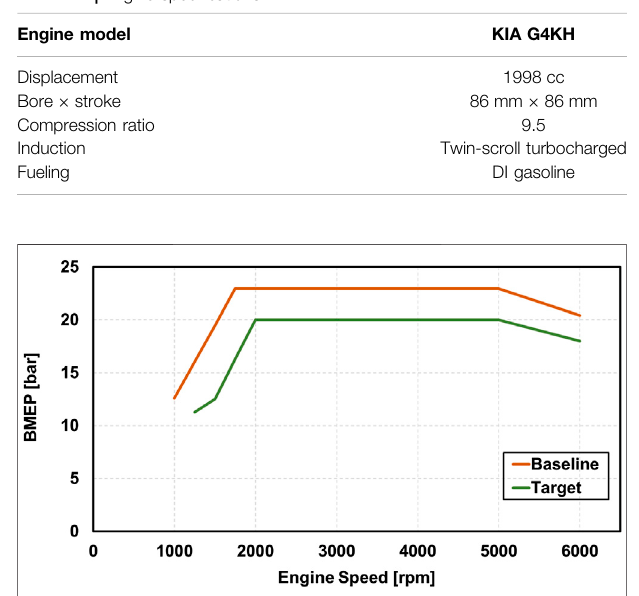
TABLE 1 | Engine speci fi cations.